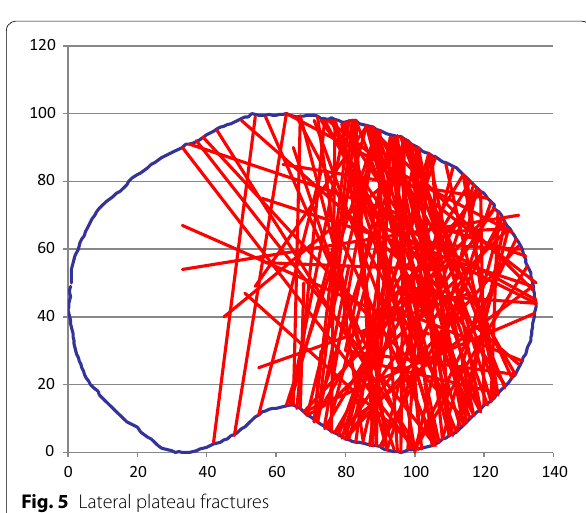
Fig. 7 Bicondylar